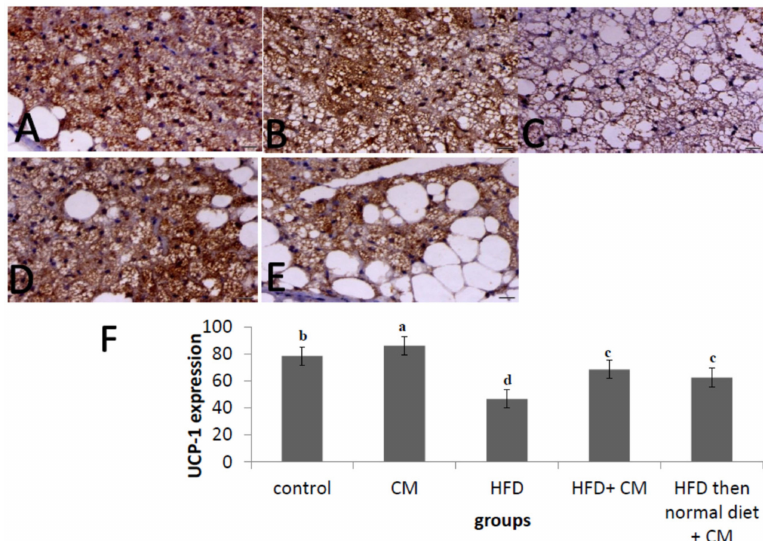
Figure 5. Photomicrograph of brown adipose tissues sections of di ff erent groups immunostained with immune reactive UCP1 primary antibody. Rats were reared, fed and treated as Figure 1. Brown adipose tissue of control animal showing marked expression of UCP1 within the cytoplasm of adipocytes, UCP1 IHC, bar = 40 µ m, X400 ( A ). Brown adipose tissue of normal animal supplemented with Myrrha showing marked expression of UCP1, UCP1 IHC, bar = 40 µ m, X400 ( B ). Brown adipose tissue of HFD-treated animal showing marked decrease the expression of UCP1 within the cytoplasm of adipocytes, UCP1 IHC, bar = 40 µ m, X400 ( C ). Brown adipose tissue of HFD + Myrrha-treated animal (14 weeks) showing increase the expression of UCP1, UCP1 IHC, bar = 40 µ m, X400 ( D ). Brown adipose tissue of HFD for (8 weeks) then basal diet + Myrrha-treated animal (6 weeks) showing increase the expression of UCP1, UCP1 IHC, bar = 40 µ m, X40 ( E ). The labeling index of UCP1 was expressed as the percentage of positive area cells in about 8 high power fields using Image J analysis software (NIH, USA) ( F ). Values presented are the mean ± SE. Columns with di ff erent letters means significant di ff erence ( p < 0.05) from the other